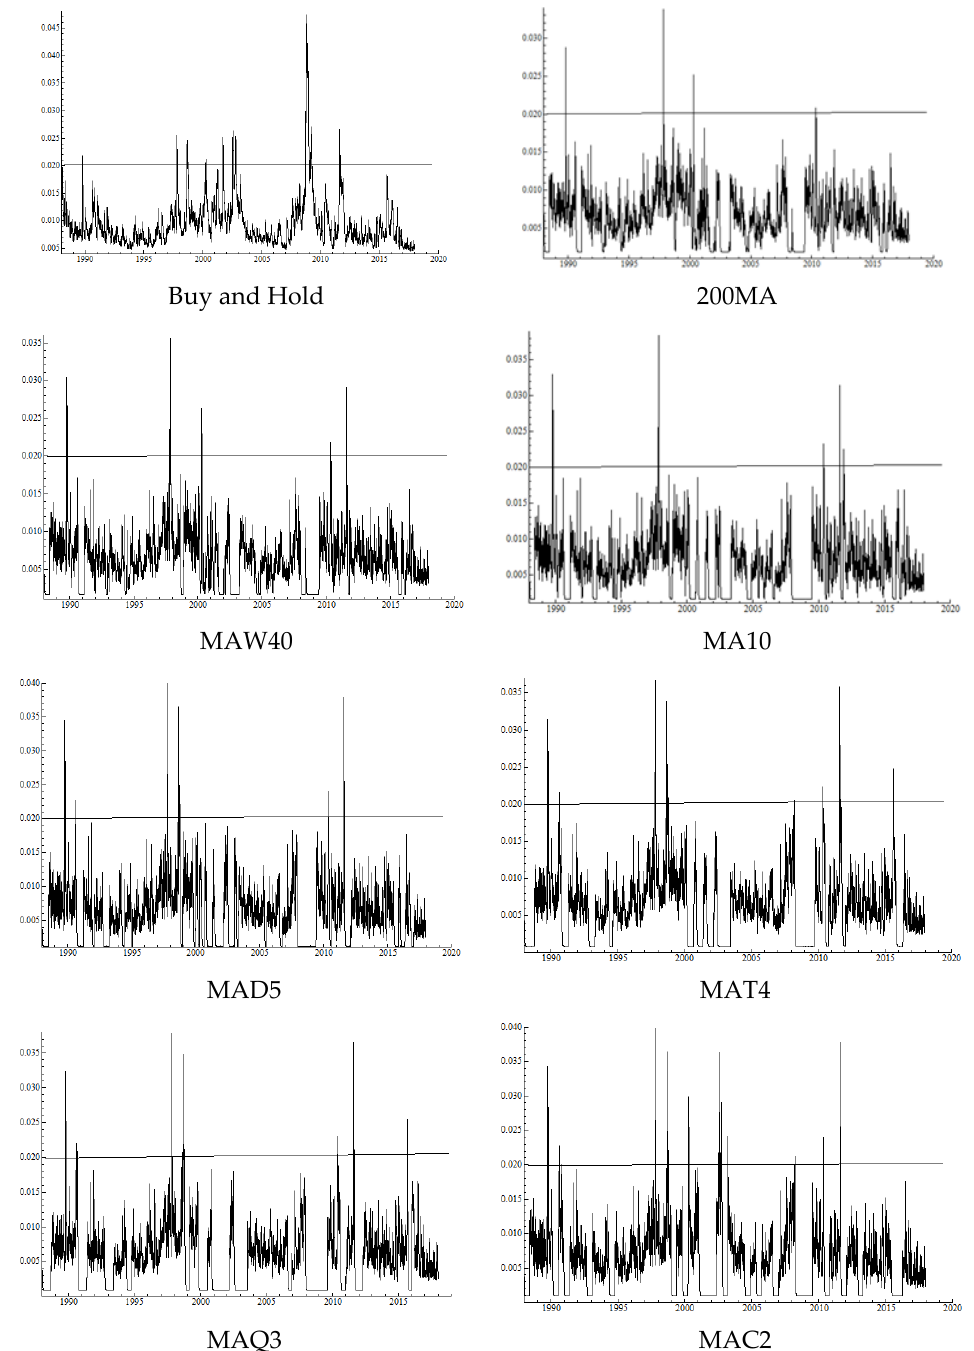
Figure 1. Realized volatilities in 200 trading days rolling window are used. The straight line is the 2% realized volatility bound.